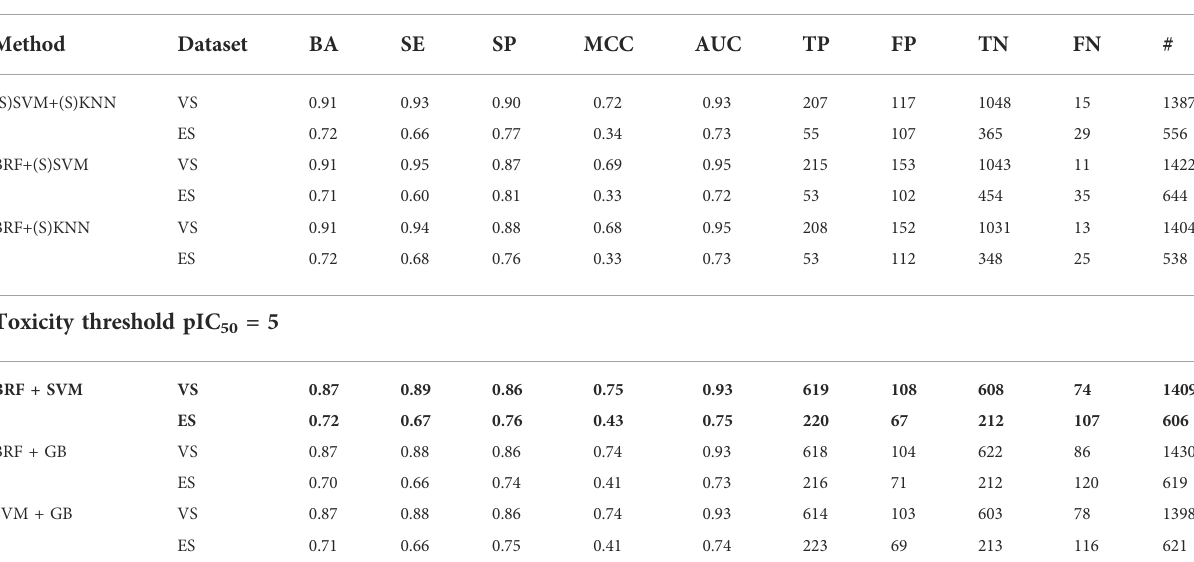
TABLE3PerformanceoftheconsensusmodelsontheVSandontheES(temporalvalidation)developedusingpIC 50 =6(top)and5(bottom).Foreach model,the following statistics arereported:balancedaccuracy (BA),sensitivity(SE),speci fi city(SP),Matthewscorrelationcoef fi cient(MCC),area under the ROC (AUC), number of true negatives (TNs), false positives (FPs), true positives (TPs), false negatives (FNs), and the total number of molecules (#). The top-performing models selected for temporal validation are indicated in